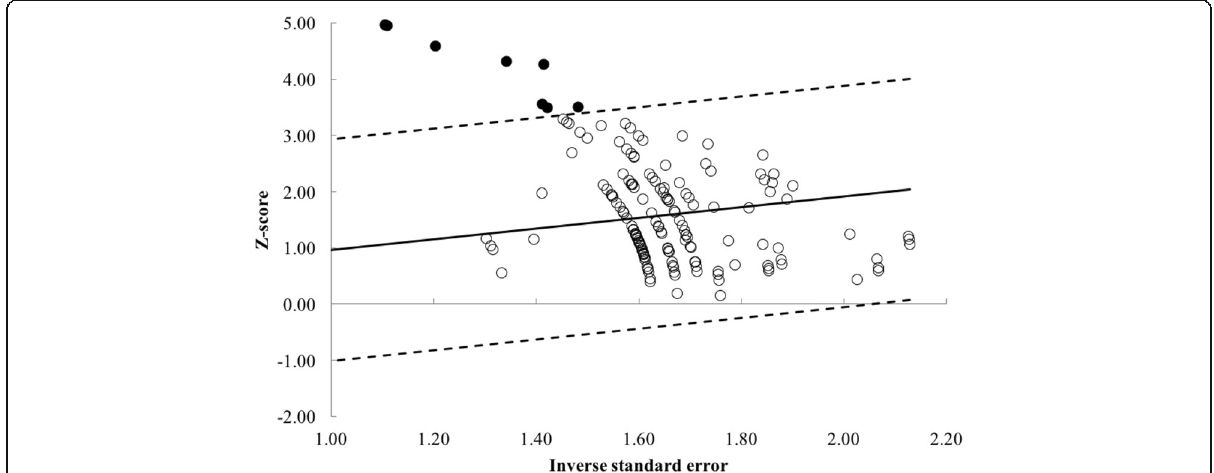
Fig. 2 Galbraith plot used to examine study heterogeneity (pre- vs. post-strength change). Each dot represents one pre- vs. post-study data. Seven pre- vs. post-study data identified as outliers (solid filled black circles)